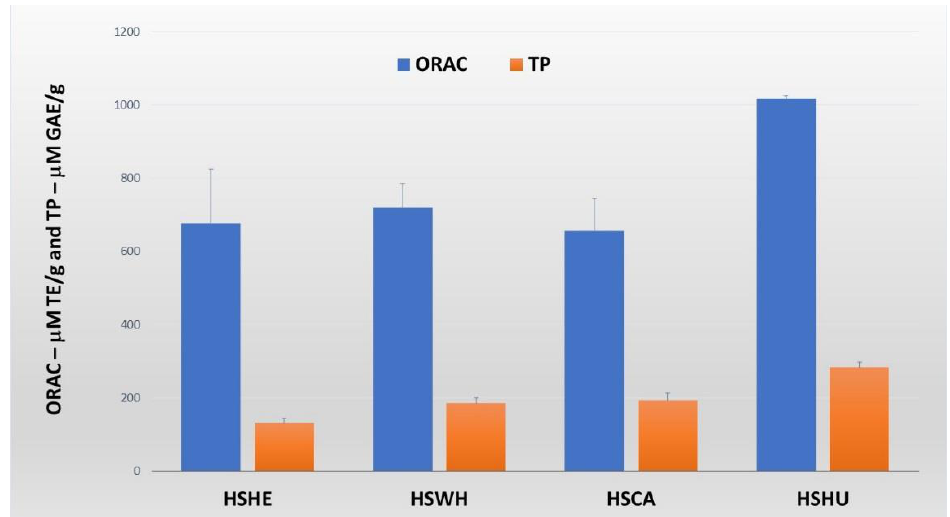
Figure 6. ORAC values and total phenolic (TP) content of protein isolates extracted from hemp seed and by-products. Data are expressed as the means ± SD (n = 4 for ORAC and n = 3 for TP). HSHE — hemp hearts; HSWH — hemp whole seed; HSCA — hemp cake; HSHU — hemp seed hulls.